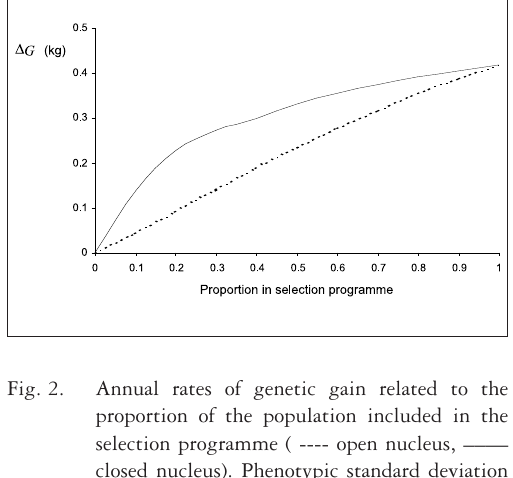
Fig. 2. Annual rates of genetic gain related to the proportion of the population included in the selection programme ( ---- open nucleus, ____ closed nucleus). Phenotypic standard deviation equal to 4.1